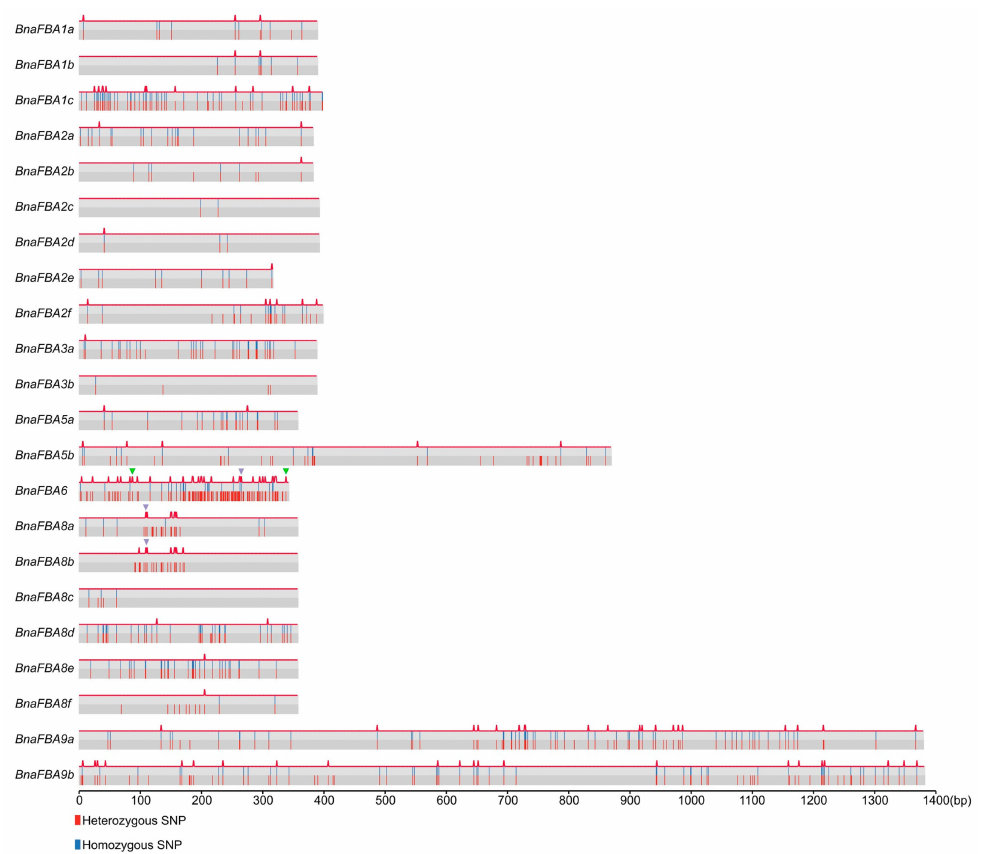
Figure 5. The variation distribution of BnaFBA genes. The heterozygous SNPs and homozygous SNPs were marked as red and blue lines, respectively. The red peak on the top of each FBA gene represents nonsynonymous variation. The green and purple triangles signify frameshift deletion / insertion and stop-gain variations, respectively. The length of the scale is placed at the